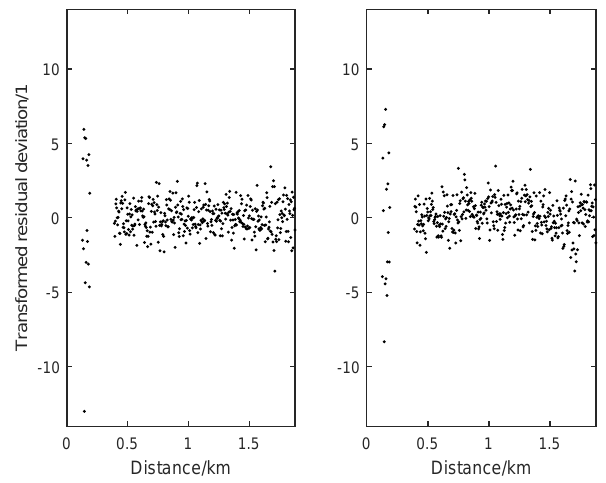
Figure 16. As Fig. 10 but for the results of the GLS approach shown in Fig. 15.